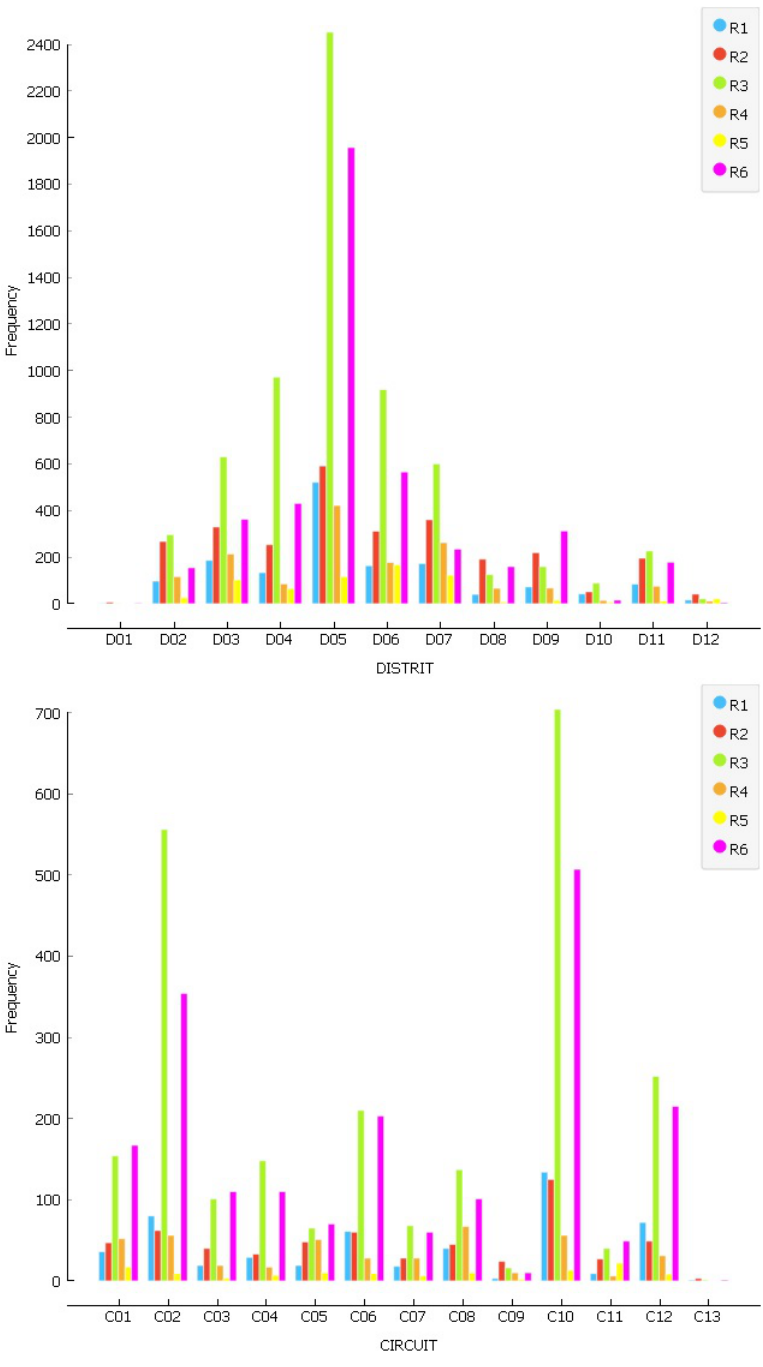
Figure 3. Frequency of Crime Types by District and